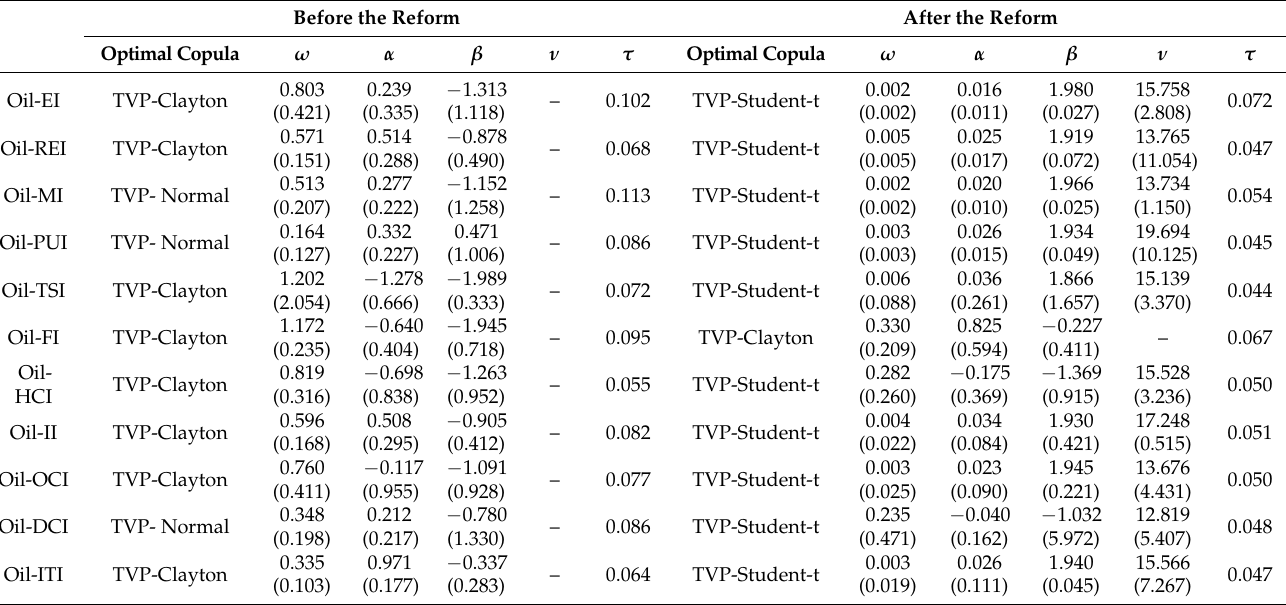
Table 5. Estimates of time-varying copula